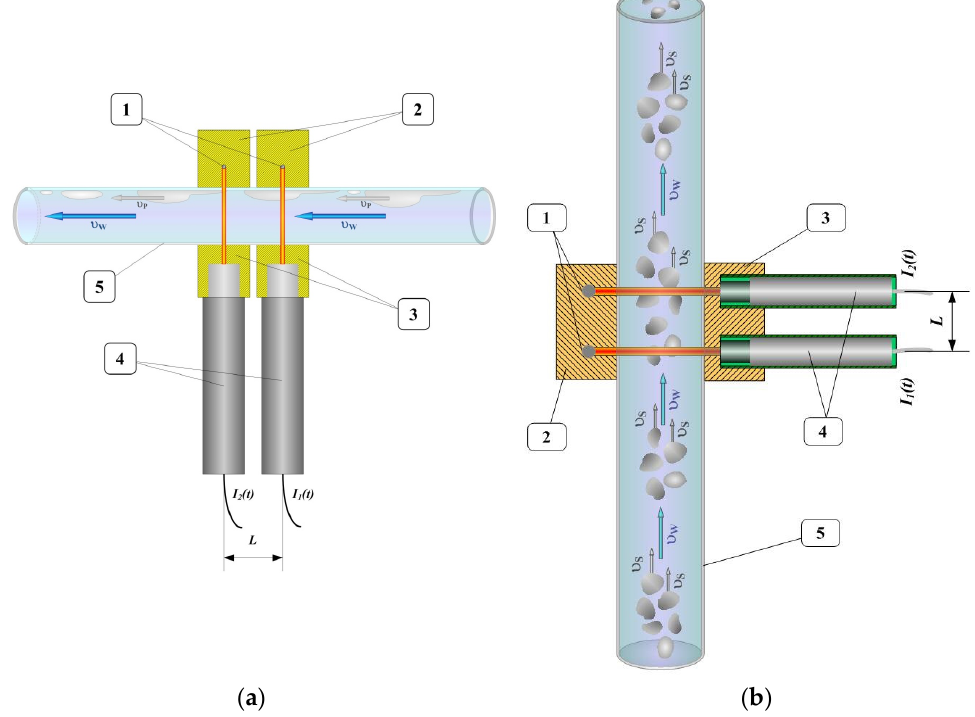
Figure 1. Basic schema of measurement of gamma absorption of the following flows: ( a ) gas–liquid flow in a horizontal pipeline and ( b ) solid particles transported by a liquid in a vertical pipe; 1—sealed gamma-ray sources; 2—lead collimator of the source; 3—lead collimator of the scintillation probes; 4—scintillation probes;